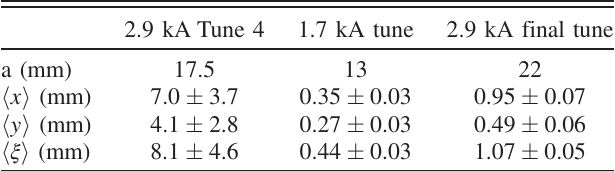
TABLE III. Calculated 2 rms radius of the beam, a, for 1.7 kA beam, the initial, and final 2.9 kA tunes in addition to the average measured BBU amplitude (in mm) for five shots in the x and the y direction and the rms value ξ . All values pertain to BPM22, z ¼ 37 . 8